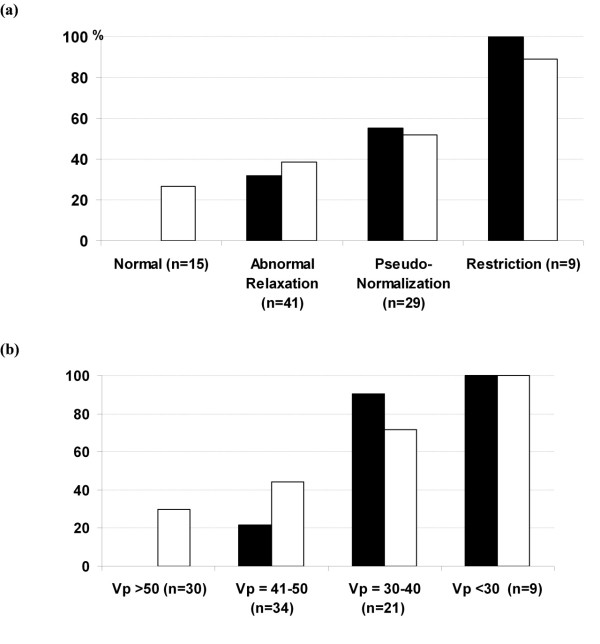
Incidence of post-cardiopulmonary bypass left ventricular dysfunction (black square) and postoperative cardiac complications (open square. Myocardial infarct, arrhythmias and/or low cardiac output syndrome) in relation with the severity of left ventricular diastolic dysfunction are expressed by standard classification (a) and by transmitral flow propagation velocity (Vp) (b).